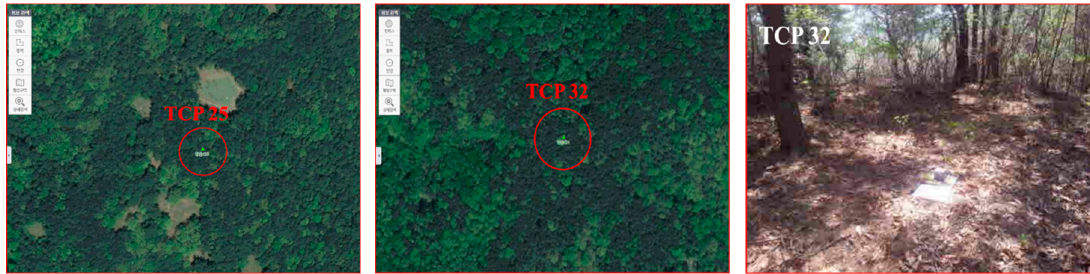
Figure 13. Aerial photos of two TCP locations (# 25 and #32) and field photo of TCP #32 from NGII.